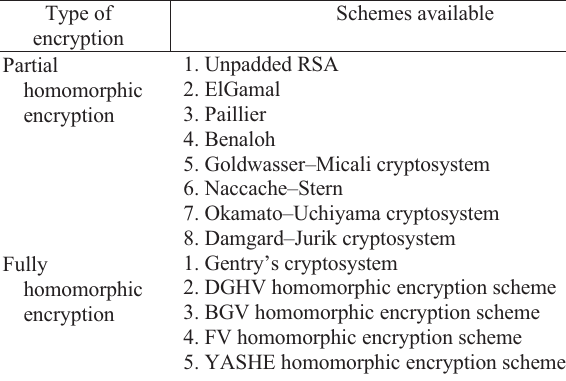
Table 1. List of homomorphic algorithms